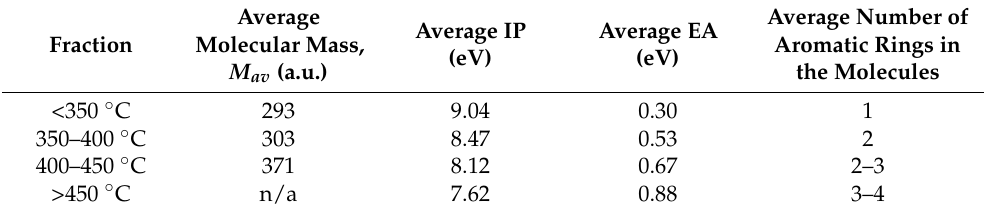
Table 7. Effective ionization potentials (IP) and electron affinities (EA) of the studied gasoil fractions. Average Average Number of Average IP Average EA Fraction Molecular Mass, Aromatic Rings in (eV) (eV) M av (a.u.) the Molecules <350 ◦ C 293 9.04 0.30 1 350–400 ◦ C 303 8.47 0.53 2 400–450 ◦ C 371 8.12 0.67 2–3 >450 ◦ C n/a 7.62 0.88